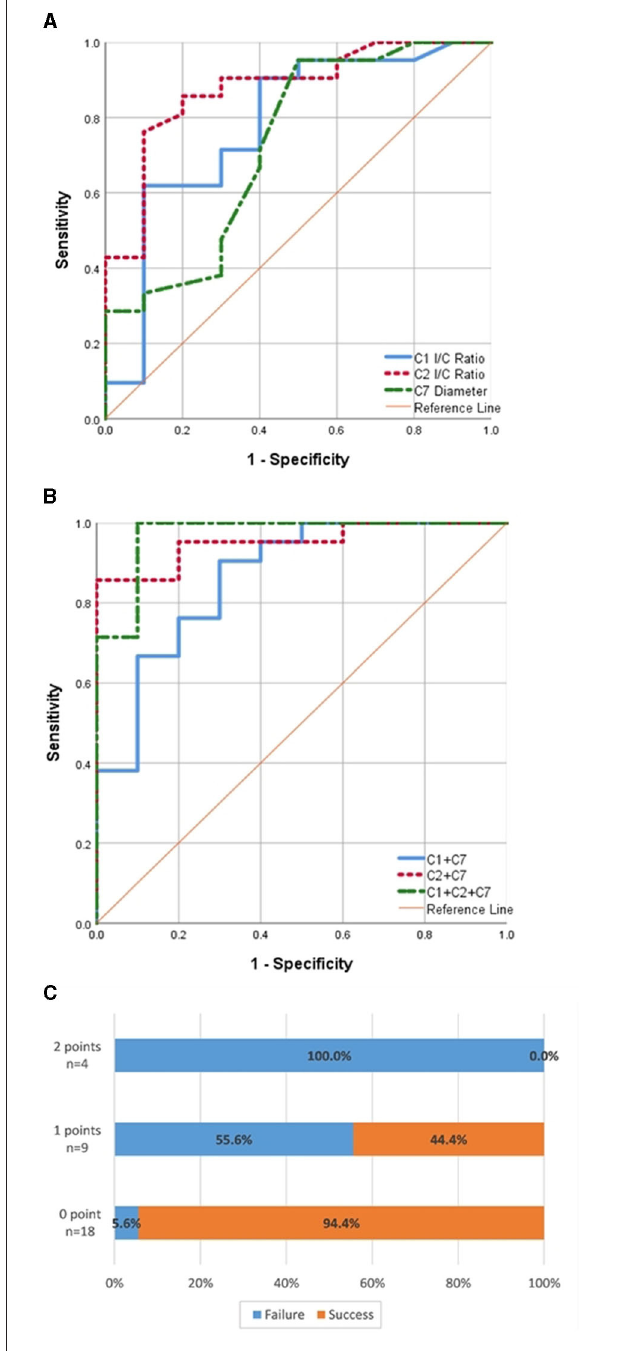
FIGURE 2 | (A) Receiver operating characteristic (ROC) curves to describe the performance of the I/C ratio of C1 or C2, the diameter of C7 in predicting the success of recanalization surgery. (B) ROC curves to describe the performance of the combination of the I/C ratio of C1 and the diameter of C7 (C1 + C7), the I/C ratio of C2 and the diameter of C7 (C2 + C7), the I/C ratio of C1 and C2 and the diameter of C7 (C1 + C2 + C7) in predicting the success of recanalization surgery. (C ) Effects of the presence of 0–2 predictive factors associated with the failure or success of recanalization. y-Axis shows each group of patients scoring 0, 1, or 2 points and the actual number of patients is marked. x-Axis shows percentage of patients who failed or succeeded in recanalization in each